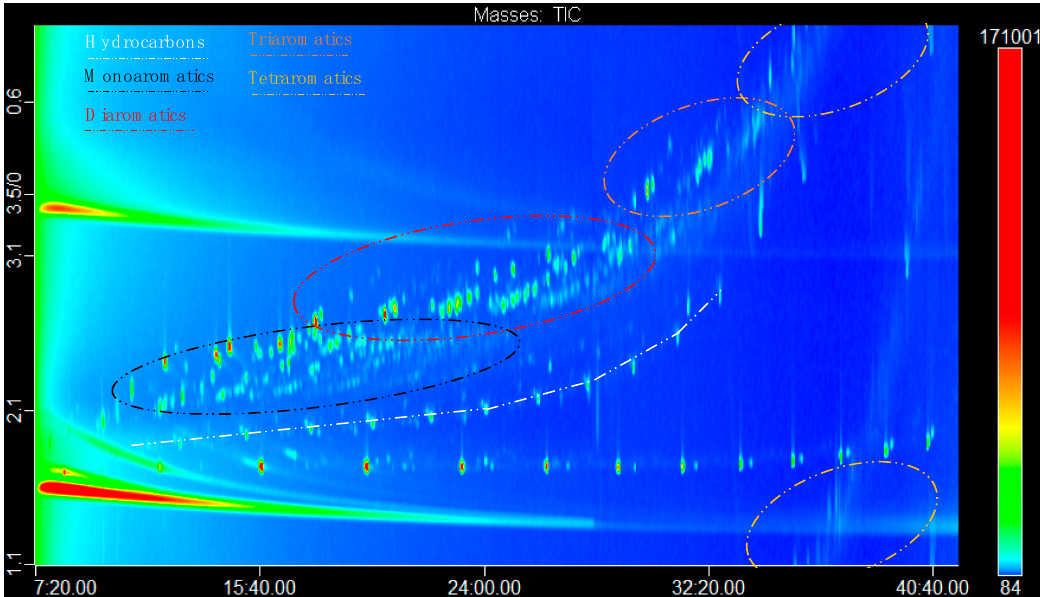
Figure 1. Total ion current GC×GC-HR ToFMS chromatogram of coal tar, highlighting the main chemical classes. Separations 2020 , 7 , x FOR PEER REVIEW